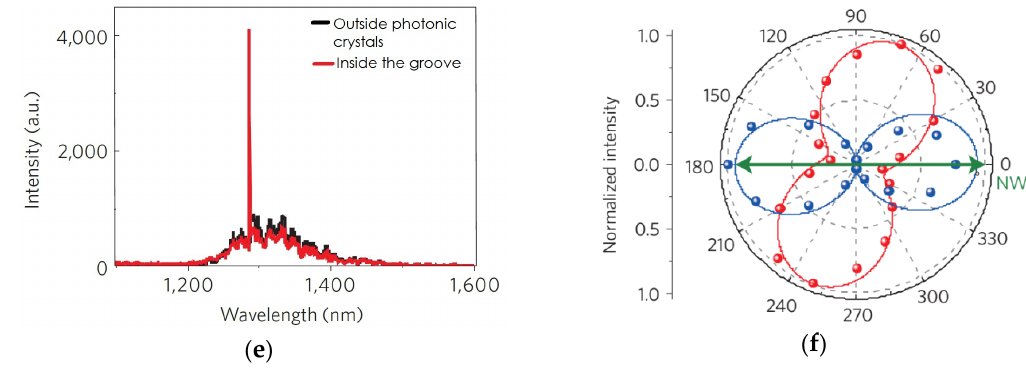
Figure 6. ( a ) The active region of our sample consists of three InGaAsP quantum wells and is embedded inside a PhC in a 240 nm ‐ thick InP membrane, and ( b ) their emission rates for different lattice constant samples from 384 to 424 nm; ( c ) Density plot of PL spectra of a quantum dot in a cavity obtained by scanning temperatures between 4 and 60 K; ( d ) A movable hybrid cavity and emitter in a photonic crystal and NWs; ( e ) PL spectra of a single NW on a bare SOI (black lines) and inside the square ‐ grooved waveguide of the photonic crystal (red lines), and ( f ) details of the cavity spectrum and the green lines show the Lorentzian fits. Figures reproduced from ( a , b ) Takiguchi, M., et al. Appl. Phys. Lett. 2013 , 103 , 091113. Copyright 2013 by American Institute of Physics Publishing LLC; ( c ) Birowosuto, M.D., et al. Sci. Rep. 2012 , 2 , 321. Copyright 2012 by Springer Nature; ( d – f ) Birowosuto, M.D., et al. Nat. Mater. 2014 , 13 , 279. Copyright 2014 by Springer